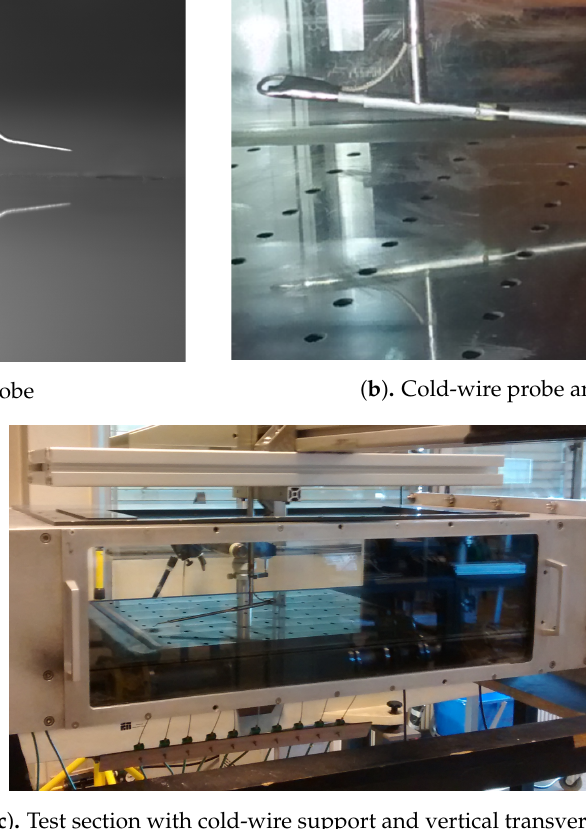
Figure 4. Cold-wire experiment—Setup and probe.